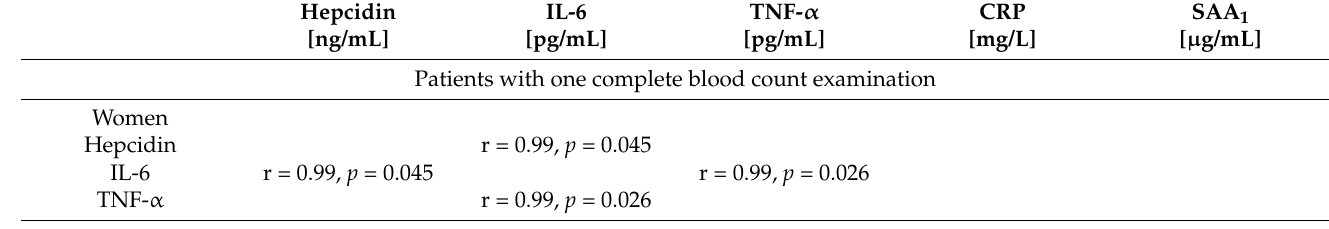
Table 3. List of statistically important correlations between analysed parameters in women and men with one complete blood count examination, as well as ≥ 3 complete blood count examinations. Hepcidin IL-6 TNF- α CRP SAA 1 [ng/mL] [pg/mL] [pg/mL] [mg/L] [ µ g/mL] Patients with one complete blood count